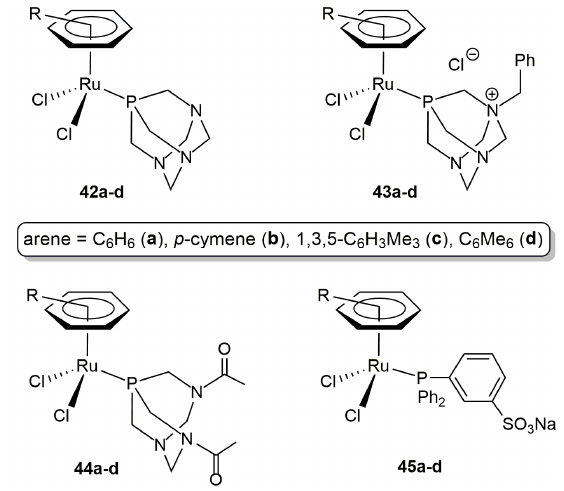
Figure 7. Structure of the water-soluble arene-ruthenium(II) complexes 42 – 45a – d .